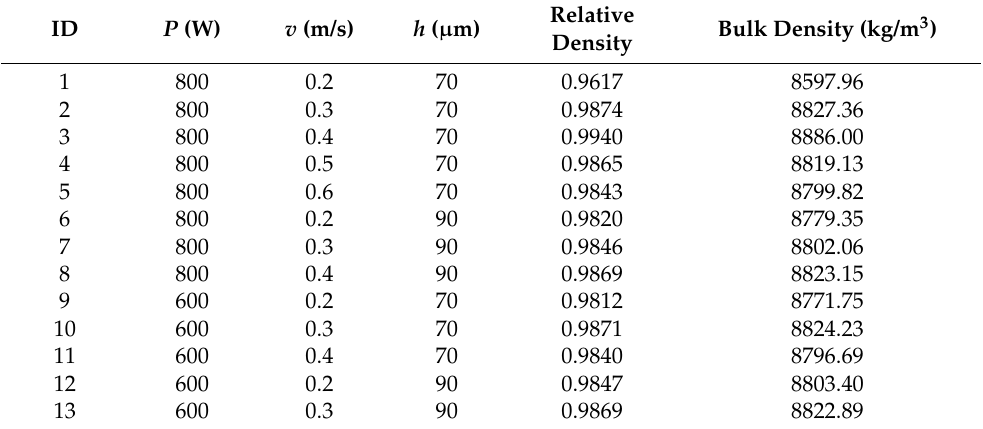
Table A17. Manufacturing parameters and experimental data, adapted from [31]. Complement- ing relevant information and assumptions are the following; material: Cu, theoretical